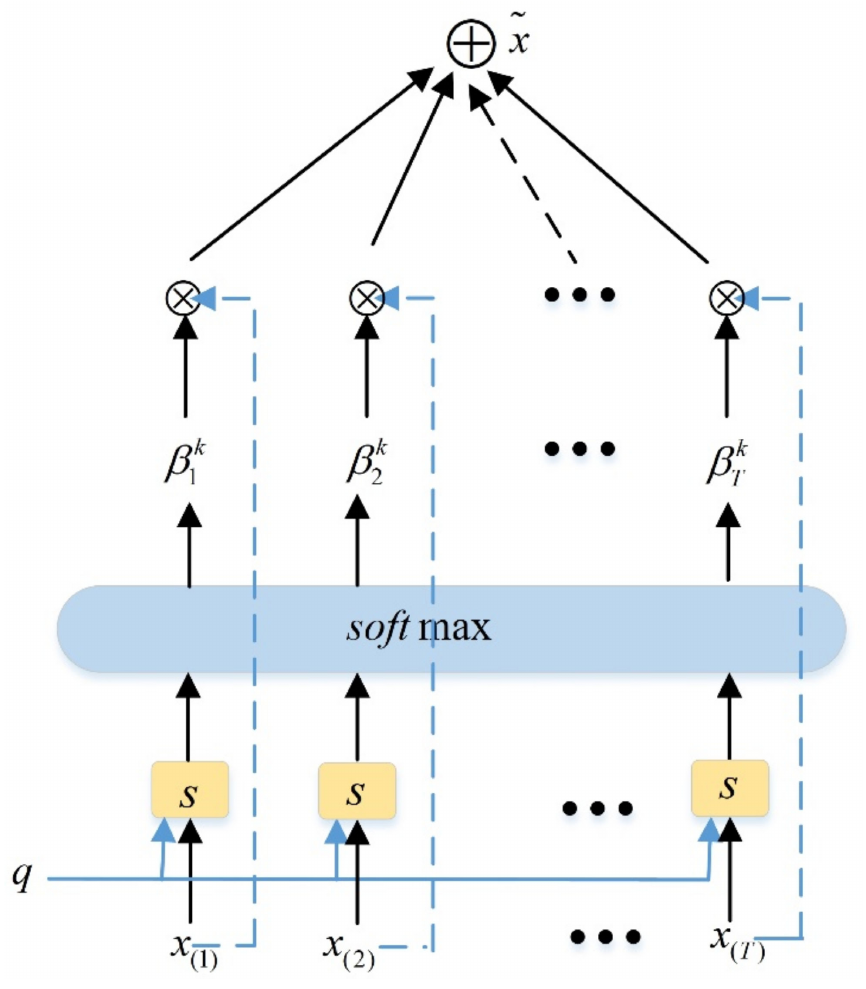
Figure 2. Attention mechanism